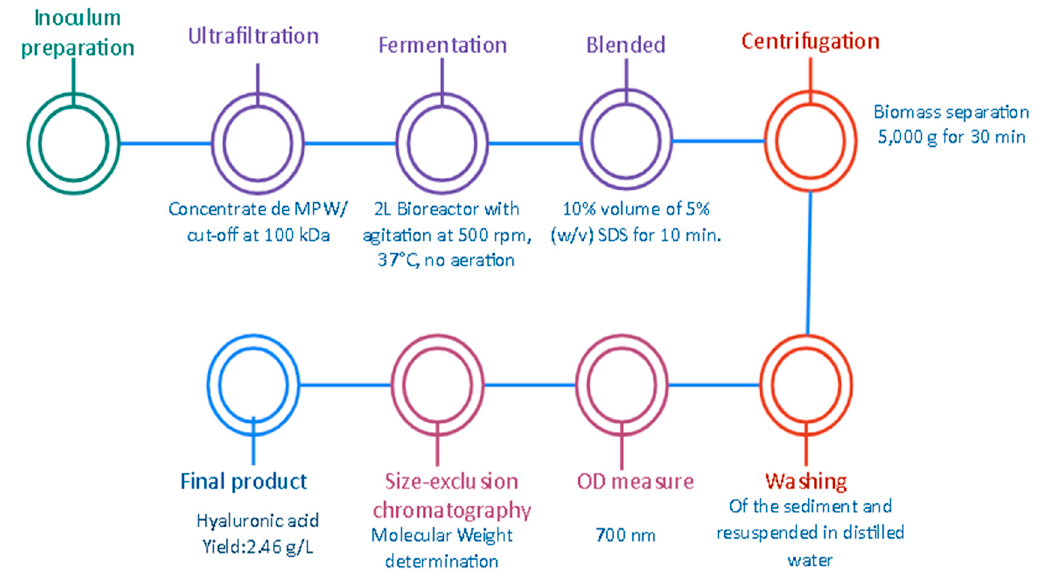
Figure 6. Production of HA by Streptococcus zooepidemicus using marine by-product media from mussel-processing wastewaters and tuna peptone viscera [23].